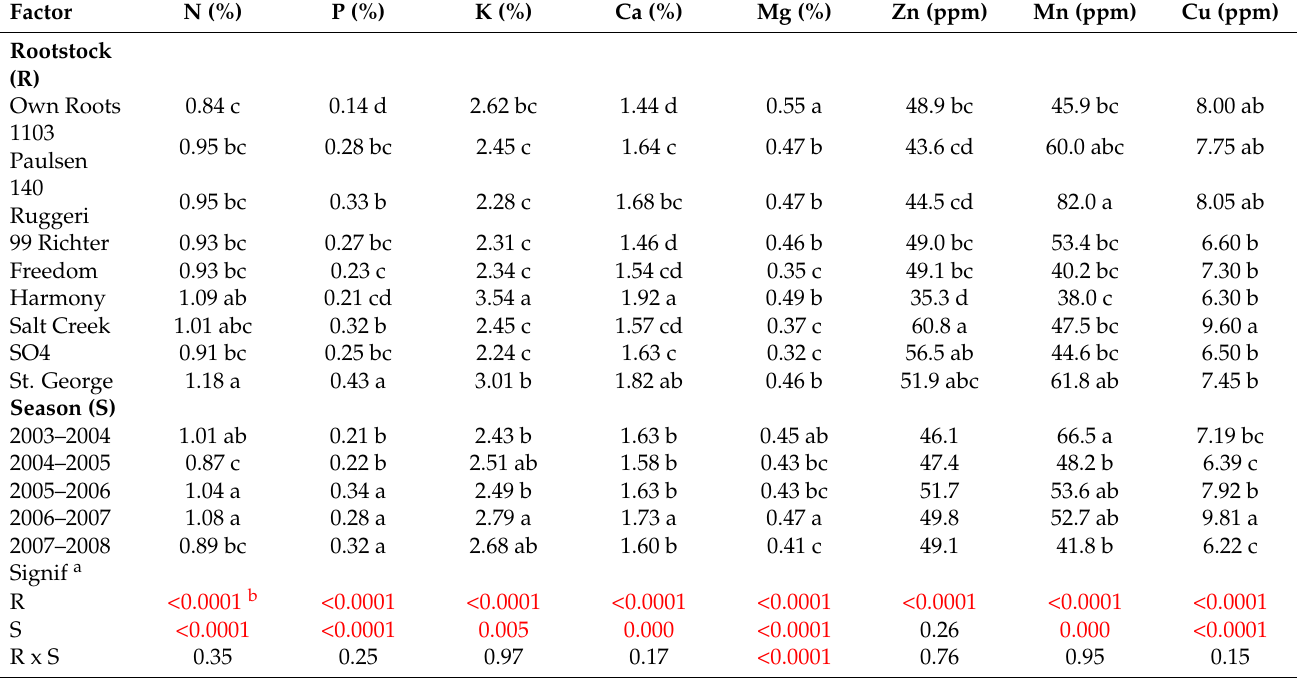
Table 5. Effect of rootstock on petiole nutrient content of Syrah grapevines growing under hyper-arid conditions over five consecutive